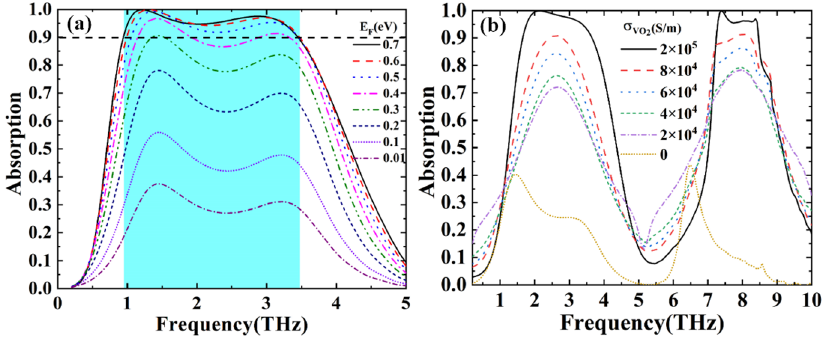
E ; ( b ) Dual broadband absorptance F